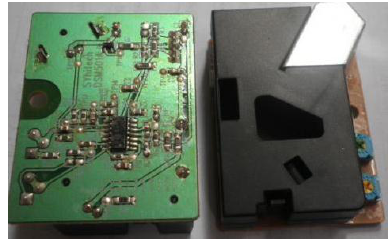
Figure 8. DSM501A particles detection module.